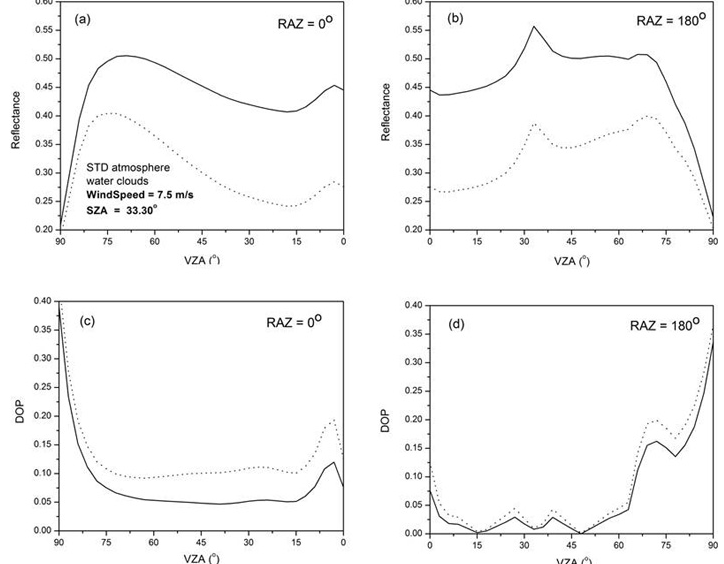
Fig. 20. The total reflectance and DOP on the principal plane, which is calculated with the ADRTM at the wavelength of 550nm from the ocean–atmosphere system with water clouds of optical thickness 5.0 (dashed curve) and 10.0 (solid curve), respectively. The ocean wind speed is 7.5ms − 1 . The SZA is 33.30 ◦ . The US STD atmosphere is used.